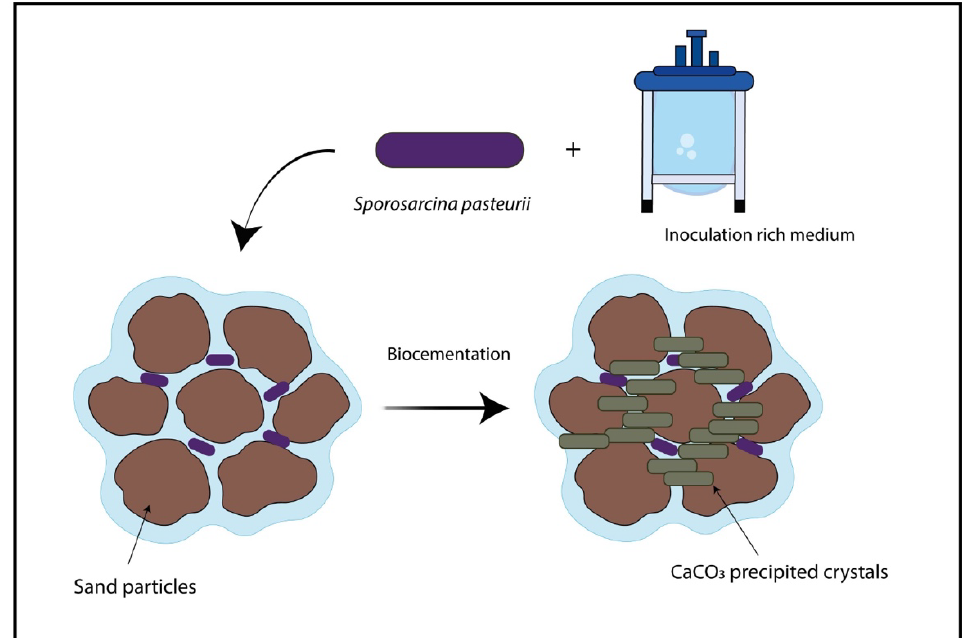
Figure 6. Simplification of the biocementation via the MICP process. The figure shows the main scheme of the process of injection of the microorganisms within an inoculation-rich medium inside the pores of the cementitious material (i.e., sand grains). In one or two days, depending on the microorganism inoculated, the precipitation of CaCO 3 crystals would enhance the adhesion and compaction of the material by occupying the pore’s space, enhancing the resistance properties of the cement.